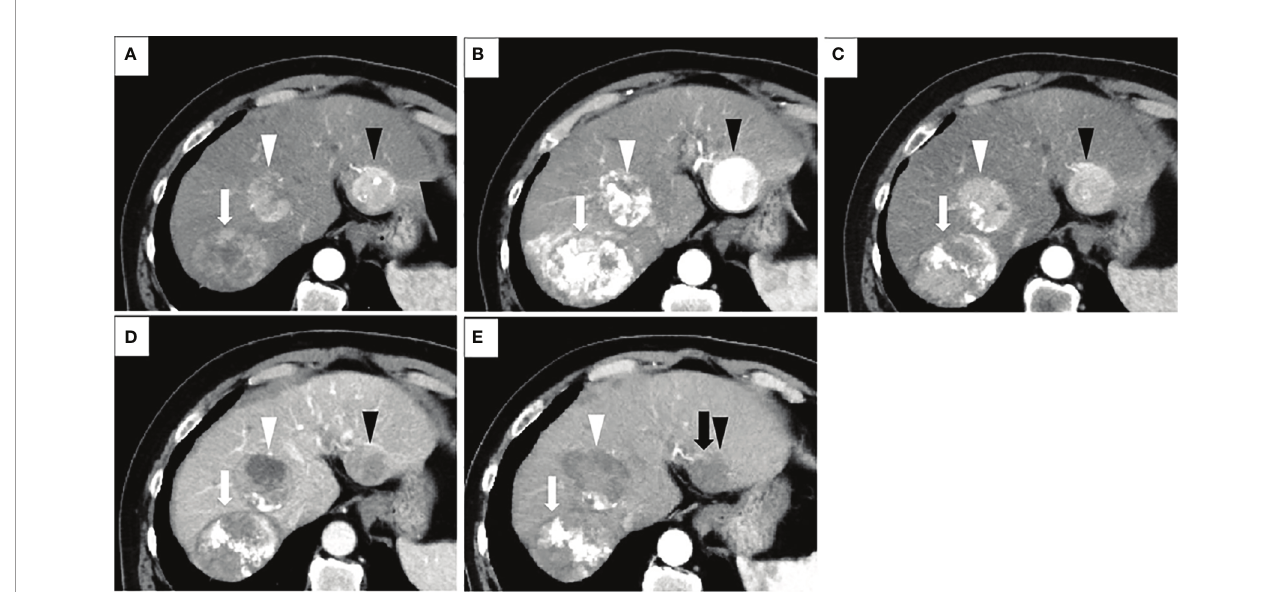
FIGURE 3 | Treatment process of a patient in the combination group who had a transcatheter arterial chemoembolization (TACE) refractory history. The patient was a 68-year-old male with no history of viral hepatitis. At the time of his initial HCC diagnosis, the sizes of the lesions were 80mm (located on segment 7 of the liver and shown as white arrows), 50mm (S4, white arrowheads), and 40mm (S2, black arrowheads). His up-to-seven score was 11, and his Child-Pugh score was A5. All of these images were taken via arterial phase of contrast-enhanced CT (CECT). Image in (A) was taken prior to the start of TACE therapy. Afterwards, this patient underwent TACE treatment three times. The images in (B, C) were taken one and four months after the third TACE operation, respectively. The sizes of the three lesions in image (C) do not show many changes when compared to their size at initial detection (A) , suggesting TACE refractory. We changed the treatment plan from TACE to lenvatinib. One and half months after lenvatinib administration, a marked decrease in tumor vascularity was observed in image (D) , while the maximum diameter of the target lesion did not change compared to its pretreatment tumor size. No newly developed lesions were observed. Therefore, this patient was evaluated as having a partial response (PR) according to the modi fi ed Response Evaluation Criteria in Solid Tumors (mRECIST). After that, three radiofrequency ablation (RFA) operations were performed. Image (E) shows that two weeks after the third RFA, all of the lesions had decreased in size, and no new lesions were detected. However, the peritumoral hyperenhancement (black arrow) of the lesion in S2 (black arrowhead) indicates a residual viable tumor. Therefore, this patient was evaluated as experiencing PR according to the mRECIST. For this patient, both the initial tumor response and the best tumor response for our combination therapy were PR.